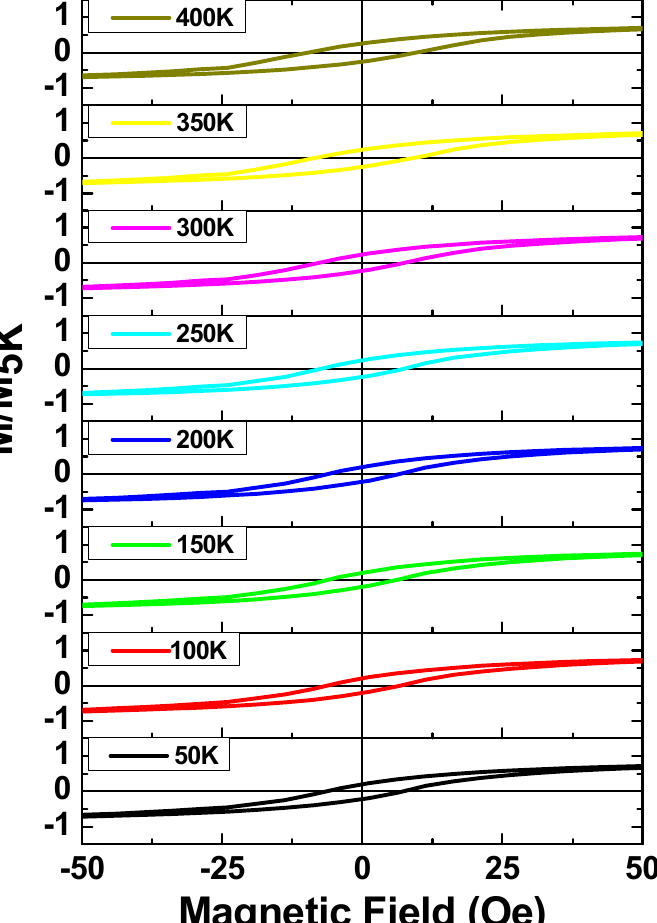
Figure 5. Hysteresis loops, measured in an applied magnetic field parallel to the axis of the microwires at different temperatures from 50 K to 400 K for as-prepared Co 2 MnSi glass-coated mi- crowires.